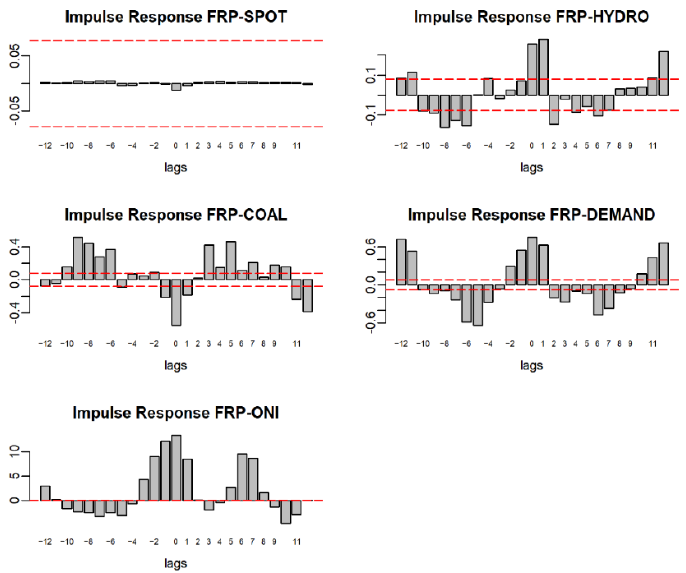
Figure 2. Impulse–response function between the FRP series and the energy variables—testing procedure. Note: From top to bottom, spot price (SPOT), total hydropower generation (HYDRO), coal power generation (COAL), electricity demand (DEMAND), and Oceanic Niño Index (ONI). After identifying the optimal transfer functions for each series, the residuals of each model ( η t ) are analyzed to verify and confirm the white noise condition in them. According to Table 5, there is a marked seasonal component at twelve periods, ( P , D , Q ) series of residuals, showing an annual market behavior on the prices of the FRP. Table 5. Results of the transfer function models for the